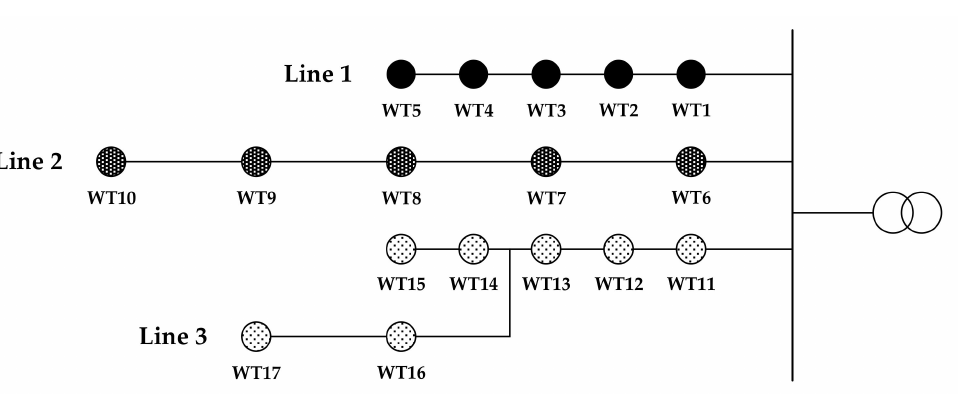
Figure 3. Topology of a wind